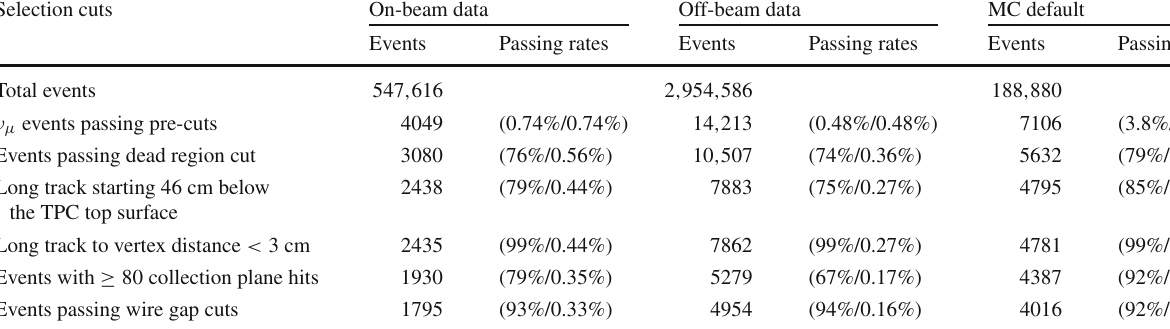
with respect to the step before (first percentage) and the absolute pass- ing rate with respect to the starting sample (second percentage)